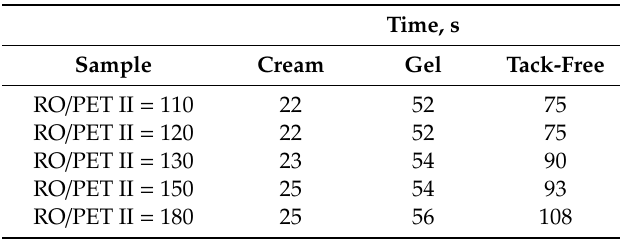
Table 3. Foaming